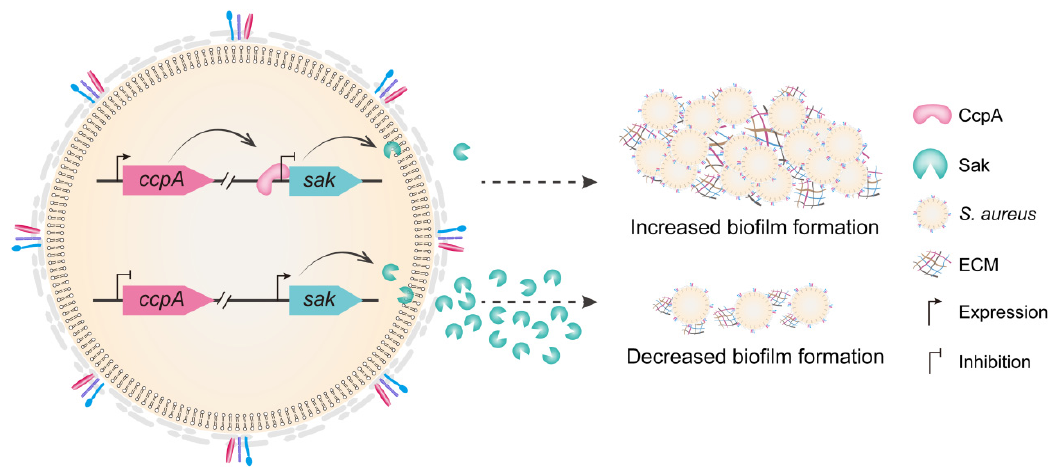
Figure 6. The conceptual model illustrating CcpA-controlled biofilm formation through direct repression of Sak production. CcpA directly binds to the promoter region of sak and inhibits sak transcription. In addition, overproduction of Sak impairs S. aureus biofilm formation either through activating plasminogen or via other cues, and the underlying mechanism remains to be fully understood. ECM, extracellular matrix.